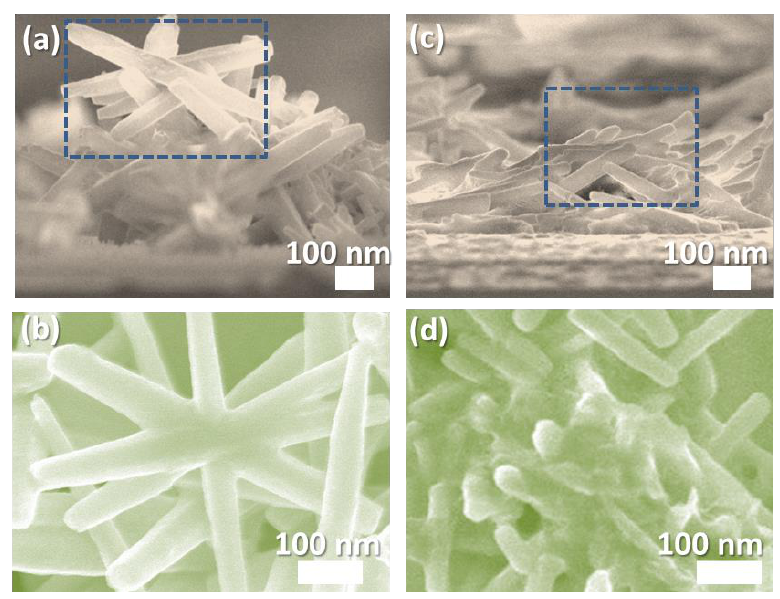
Figure 4. ( a ) Cross-sectional and ( b ) top-view SEM images of a flower-like ZnO NRAs. ( c ) Cross-sectional and ( d ) top-view SEM images of a coral-like ZnO NRAs.